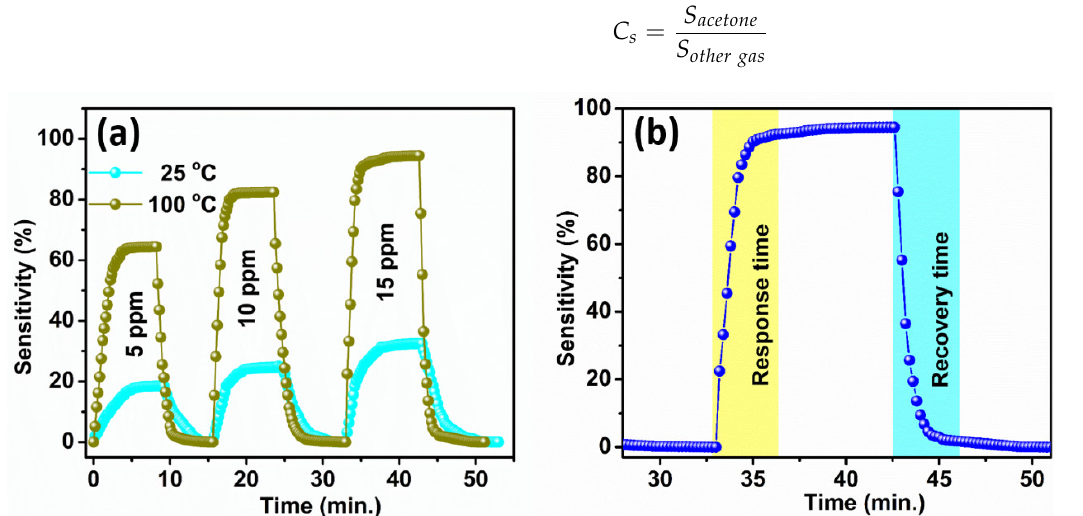
Figure 6. The WS 2 nanorod sensor: ( a ) Transient characteristics at 25 °C and 100 °C for 5, 10, and 15 ppm acetone concentrations and ( b ) estimation of response and recovery time at 100 °C for 15 ppm of acetone.